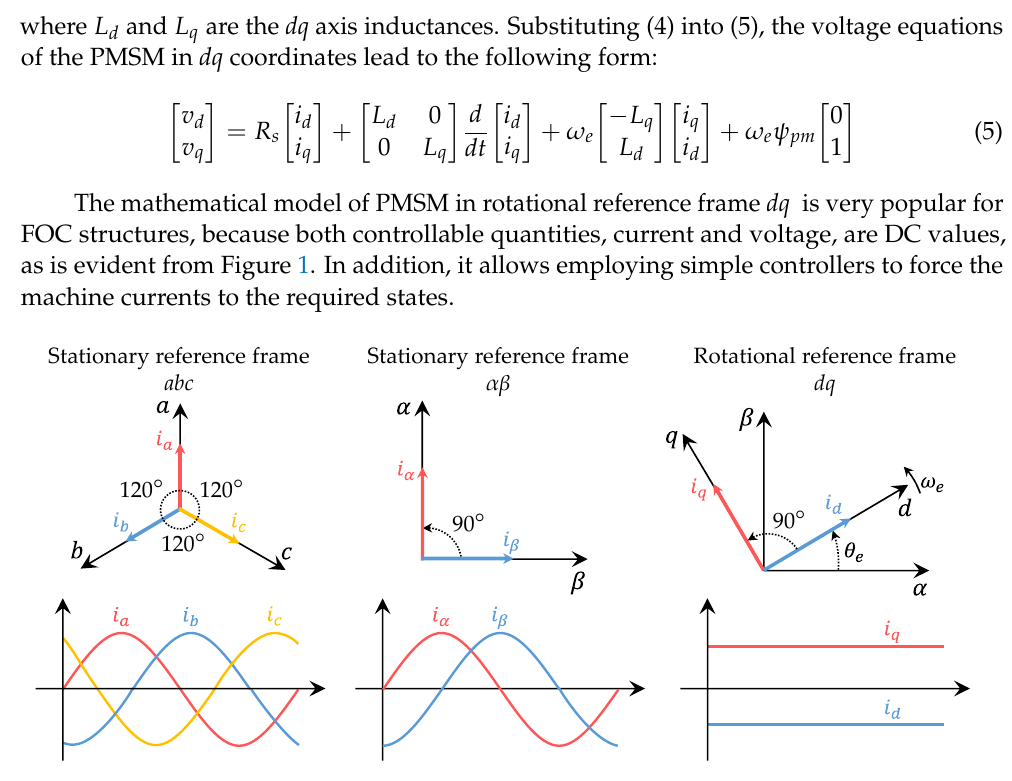
Figure 1. Transformation from stationary to rotational reference frame.